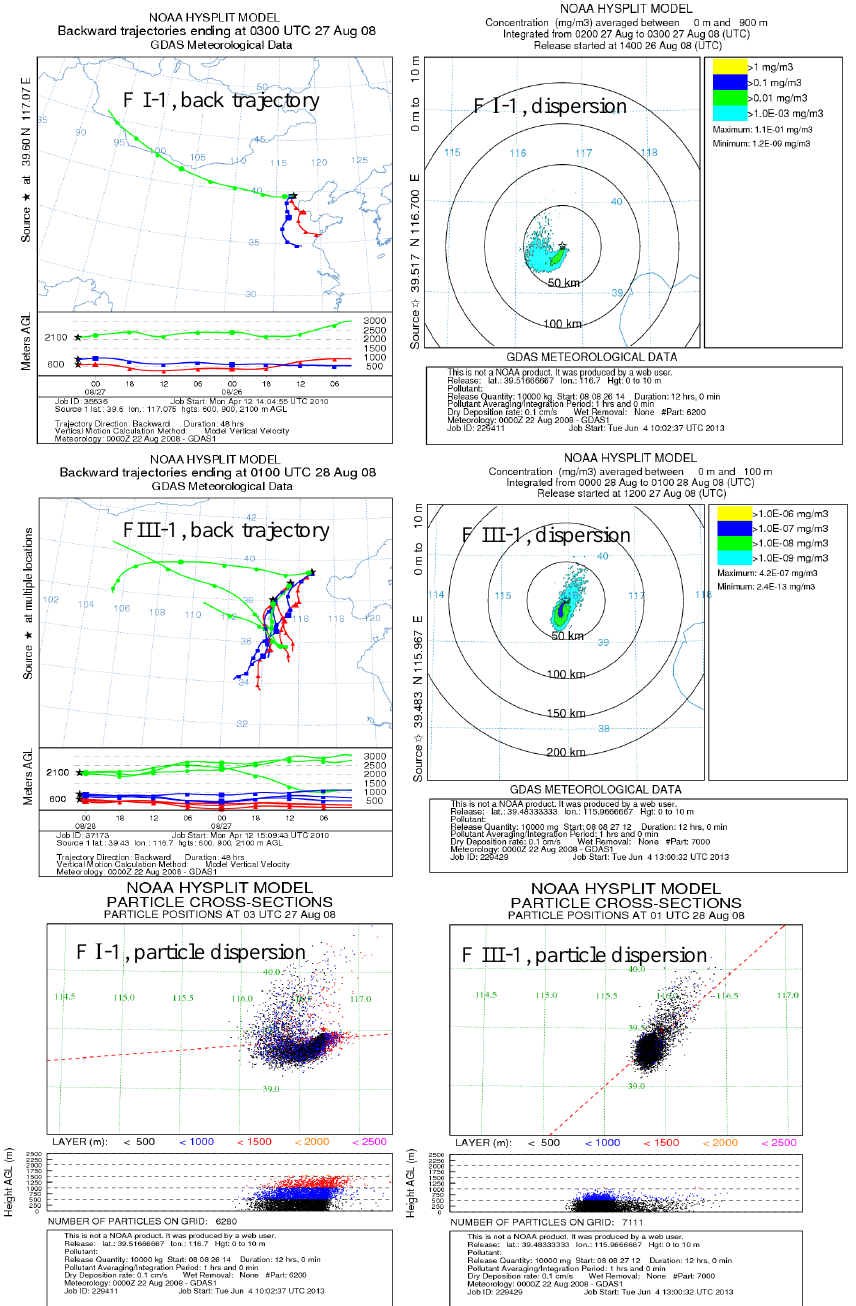
Fig. 3 A 48 h back trajectories and 12 h forecast dispersions for Flight Ι-1 and III-1 Fig. 3. 48h back trajectories and 12h forecast dispersions for flights I-1 and III-1 of G1. of G1. more local pollutants (Guo et al., 2004; Van Pinxteren et al.,